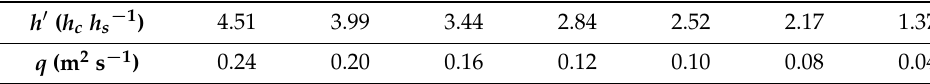
Figure 5. The geometric parameters of the block. Table 1. Values of h ’ and q used in the tests.